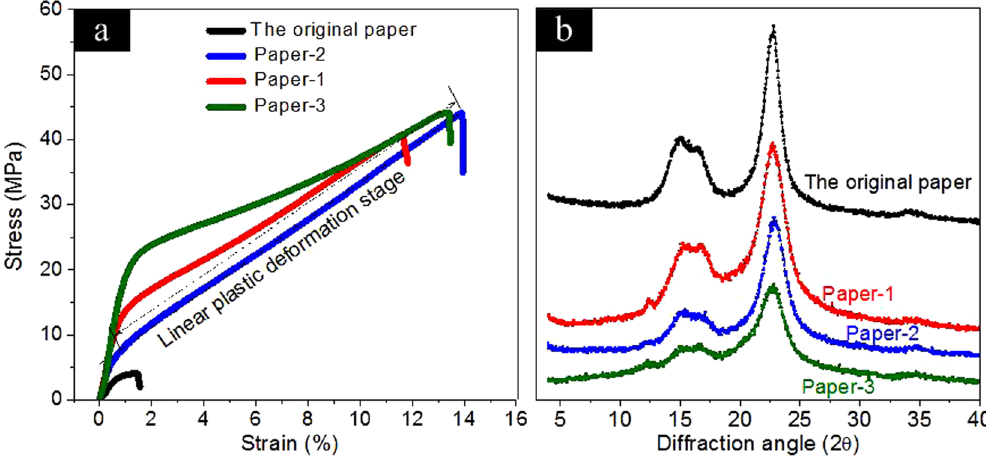
Figure 5. Stress-strain curves ( a ) and XRD curves ( b ) of the Paper-1, Paper-2, Paper-3 and original paper